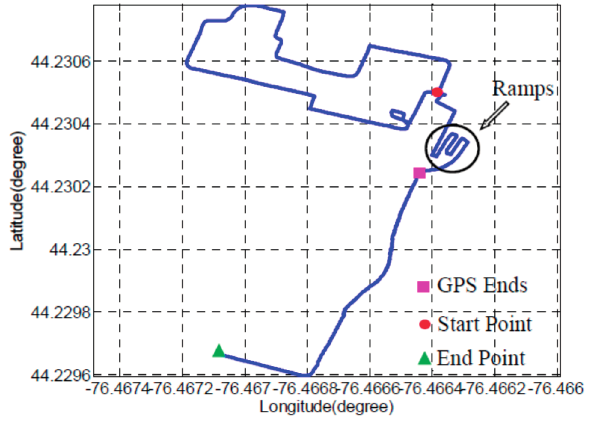
Figure 4. The generated trajectory from tightly coupled navigation system.